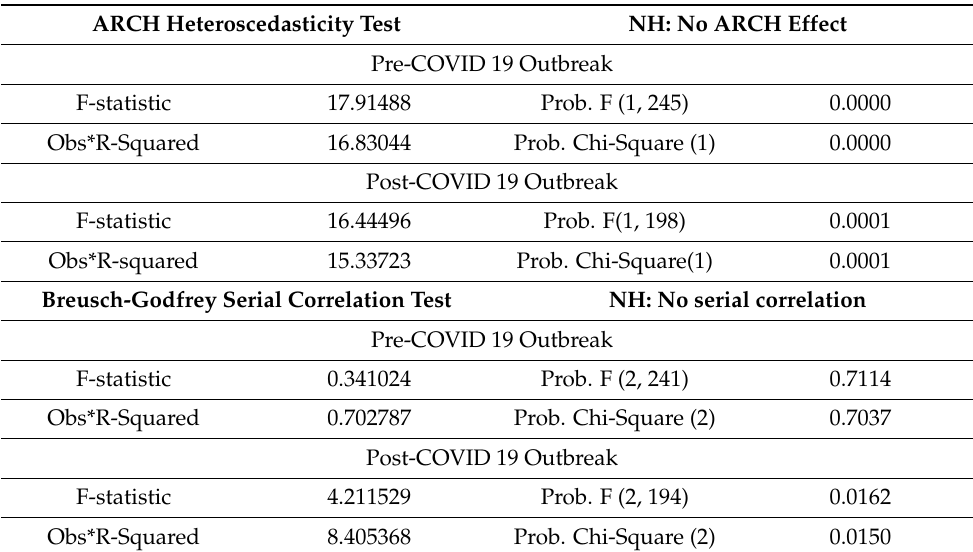
Figure 2. Residual time plot of OLS regression. ( a ) Pre-COVID 19 residual plot; ( b ) Post-COVID 19 residual plot. Table 5. Diagnostic tests for OLS Regression analysis.